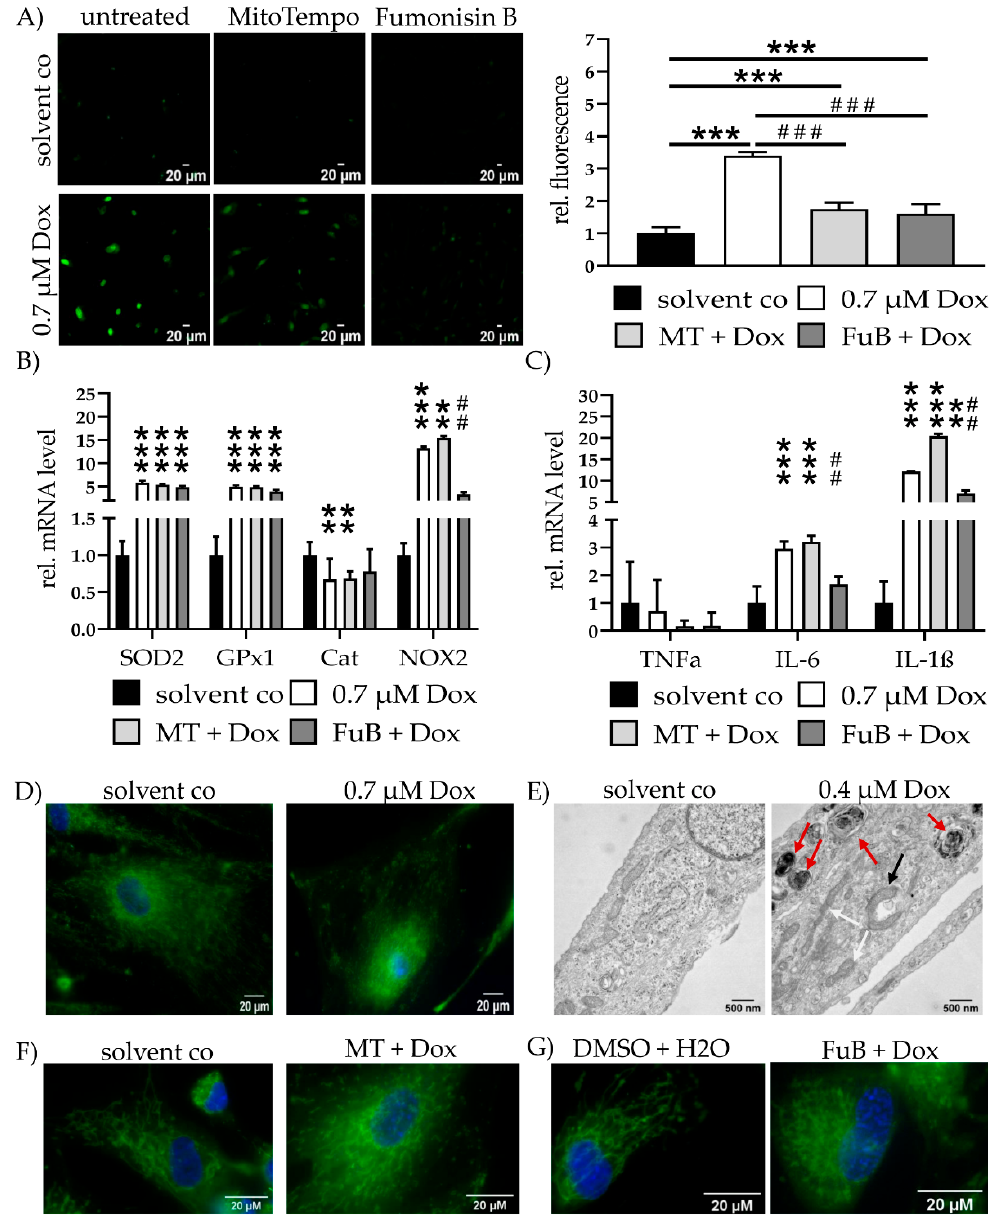
Figure 2. Mitochondrial Homeostasis—Mitochondrial ROS Production, Inflammation and Structure. ( A ) Mitochondrial ROS production was visualized with MitoSOX (green) and measured with cLSM. Pictures depict six representative images of three independent measurements. ( B ) mRNA expression levels of ROS scavenger ( SOD2, GPx1, Cat ) and inducer ( NOX2 ). ( C ) mRNA expression levels of inflammatory cytokines ( TNF α , IL-6, IL-1 β ). ( D ) Mitochondrial structure visualized with MitoTracker (green) and cLSM. Nucleus was stained blue. ( E ) Electron microscopy of cells treated with solvent co and 0.4 µ M at 20,000 × magnification. Red arrows indicate multilamellar bodies. Black arrow highlights an early autophagosome encapsulating a mitochondrion. White arrows show physiological tube-like mitochondria. ( F ) Cells were pre-treated with MT and subsequently treated with Dox. Mitochondrial structure visualized with MitoTracker (green) and cLSM. Nucleus was stained blue. Pre-treatment shows less impaired mitochondrial structure but no complete reversion to solvent co. ( G ) Cells were pre-treated with FuB and subsequently treated with Dox. Mitochondrial structure visualized with MitoTracker (green) and cLSM. Nucleus was stained blue. Pre-treatment with FuB restored some of the physiological net-like mitochondrial structure. Depicted are mean values and standard deviation of minimum 3 biological replicates. Significances were calculated with a t -test. (**/ ## p ≤ 0.01, ***/ ### p ≤ 0.001).